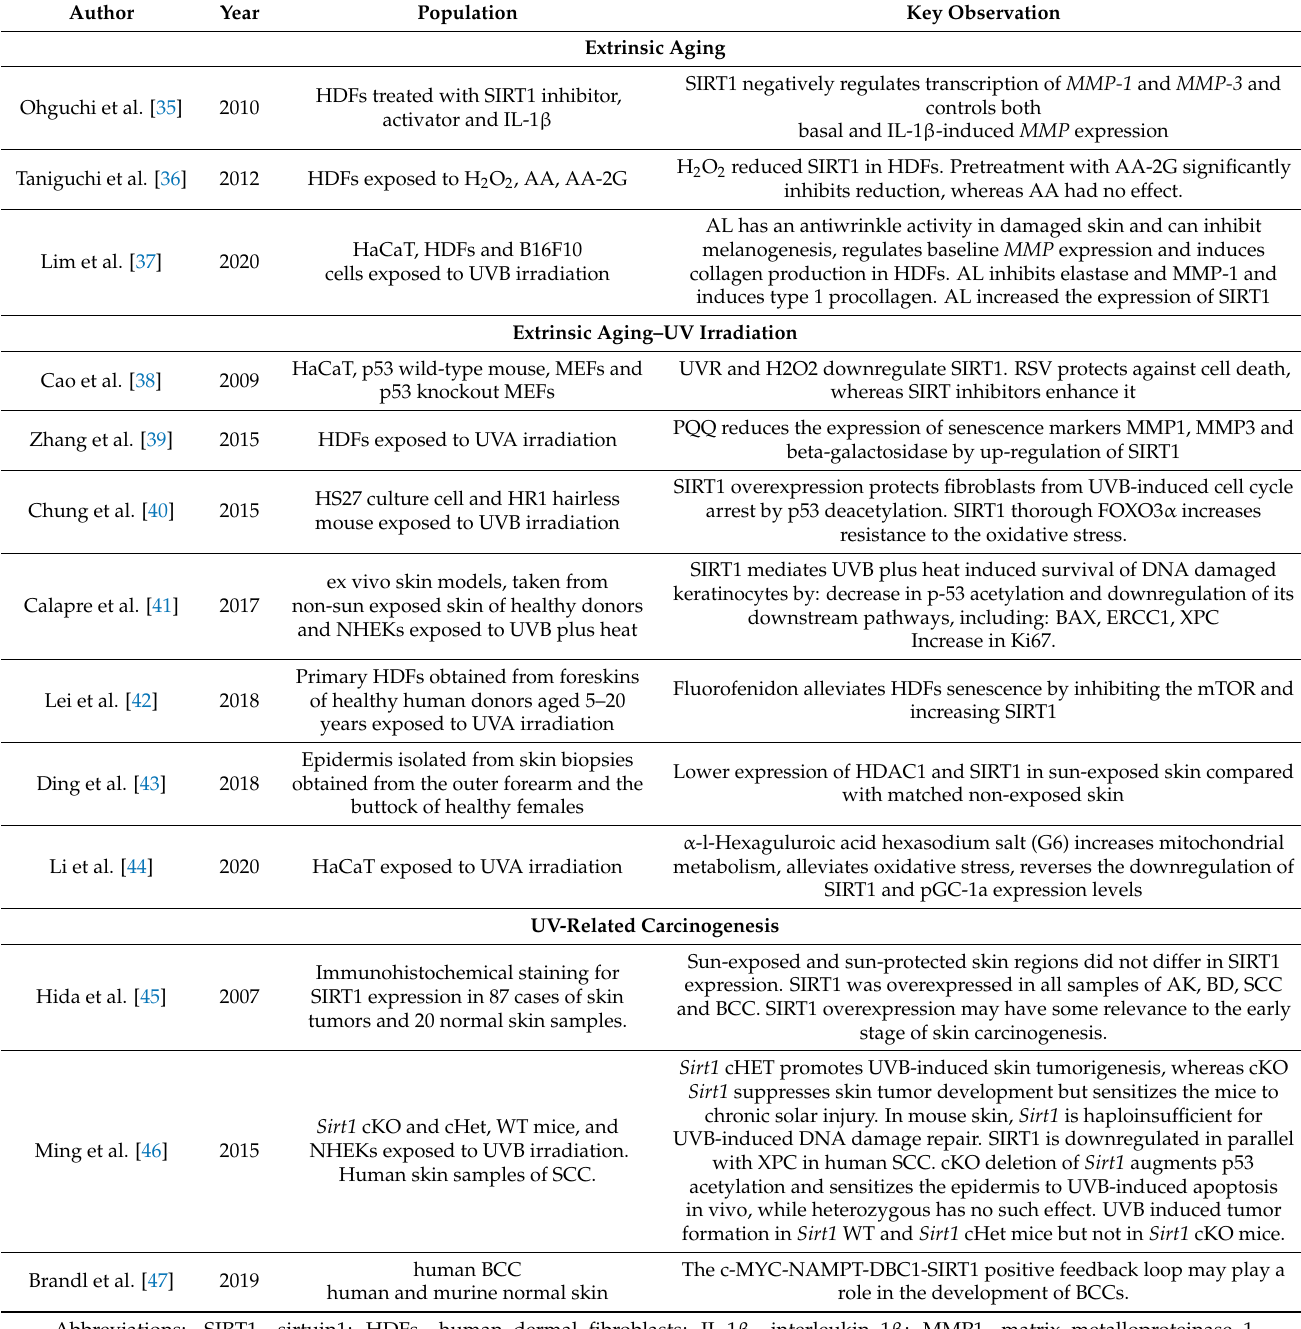
Table 3. Summary of the studies on SIRT1 relevance in extrinsic